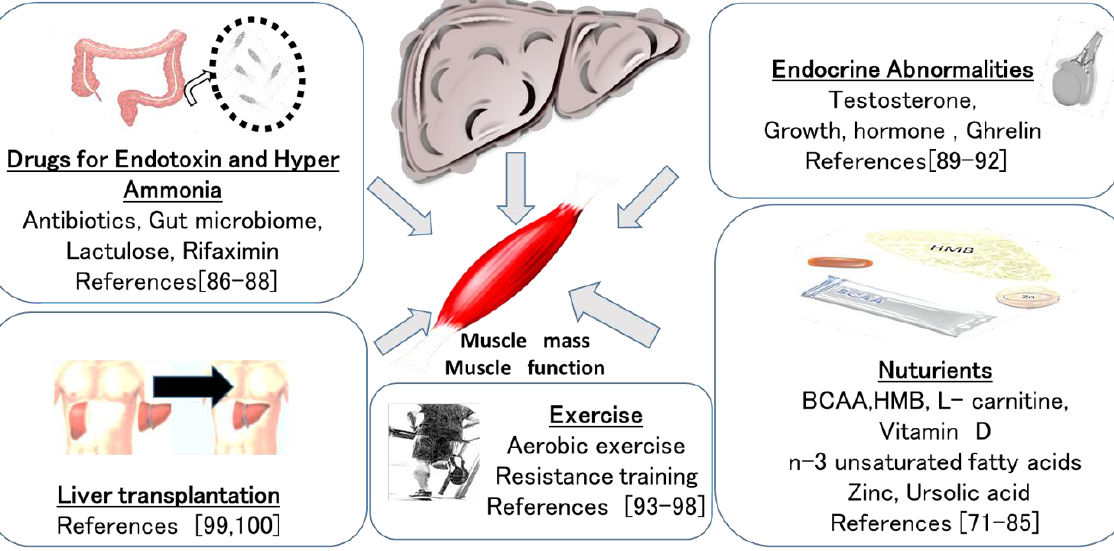
Figure 3. Treatment interventions for liver disease and sarcopenia.